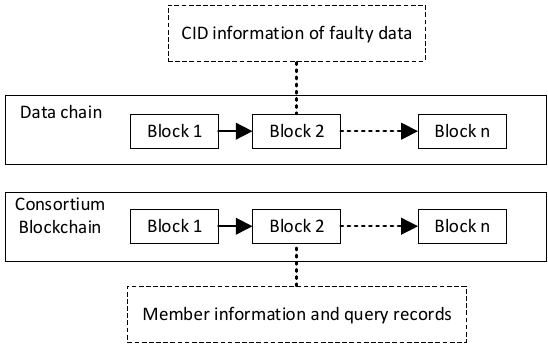
Figure 1. Data link and federation link basic structures.